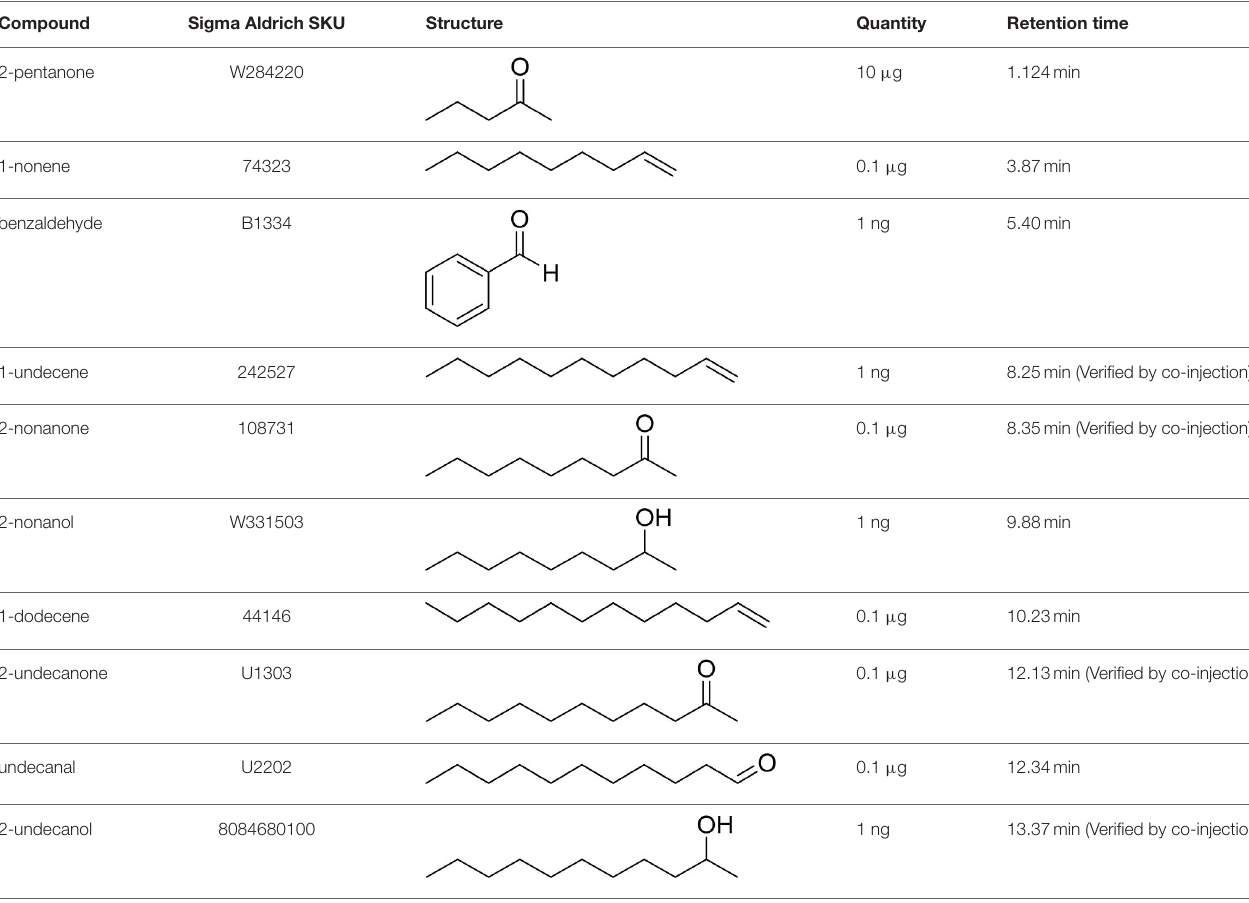
TABLE 2 | Chemical standards and retention times.